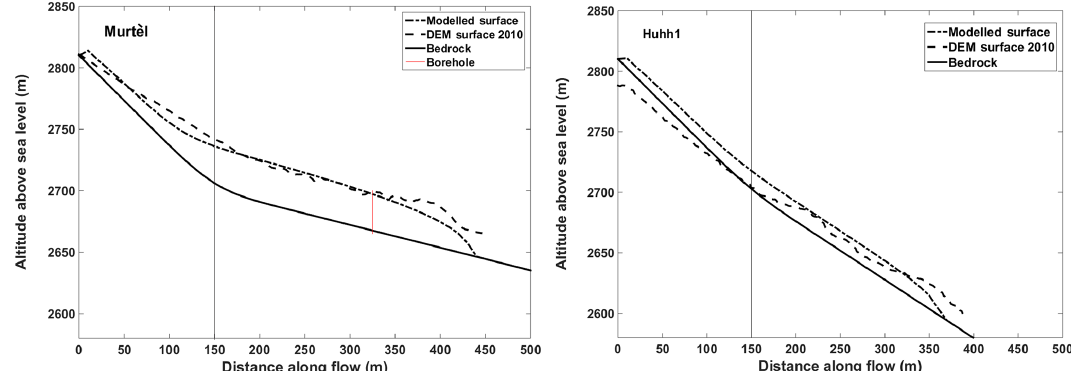
Figure 5. Observed and modeled rock glacier geometry after buildup. The along flow bed topography used in the model and the modeled and observed (from DEMs) rock glacier surfaces are shown. The vertical fine black lines mark the boundary between the deposition area (talus slope) and the main rock glacier lobe. Note that the model cannot replicate the exact geometry of the landform due to the various simplifications but shows good agreement in length and thickness of the rock glacier main body. Table 4. Comparison of the observed (obs.) and modeled (mod.) rock glacier thickness and velocity for Murtèl and Huhh1 after 6000 years and 600 years, respectively. Murtèl obs. Murtèl mod. Huhh1 obs. Huhh1 mod. Length 280m 300m 310m 240m Thickness 30m 28m 12m 16m Horizontal